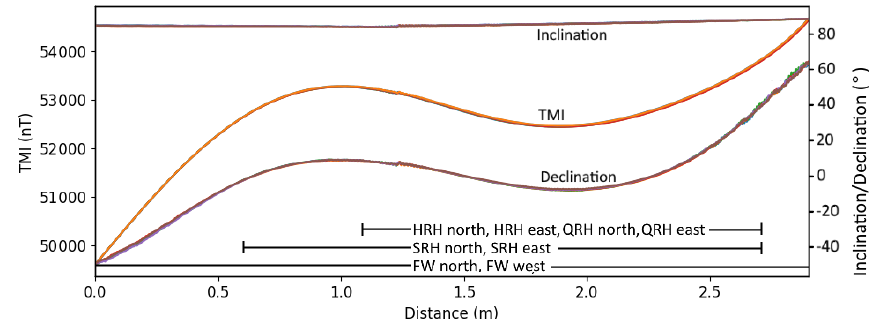
Figure 3. The total magnetic intensity (TMI), inclination, and declination profile of six background lines collected during the FW north mapping. Repeat background lines appear superimposed at this scale. The location of the line lengths (Table 2) used for each mapping is noted at the base of the plot. Table 2. Statistics on background lines for each mapping. The abbreviations used in the table are as follows: AVG denotes the average, RMSD denotes the root-mean-square deviation, SD is the standard deviation, CE line is the line closure error, and CE map is the map closure error. Mapping Line Number of Mapping AVG SD CE map length (m) background